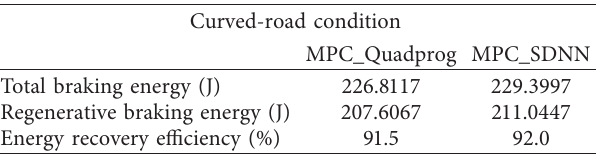
Table 17: Performance of energy recovery in braking in the curved- road condition.